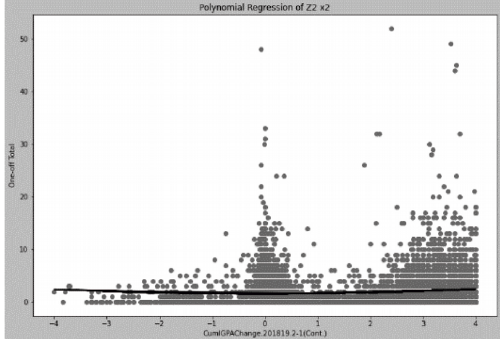
Figure 10. Polynomial Regression of Z2 x2 in Finding 1